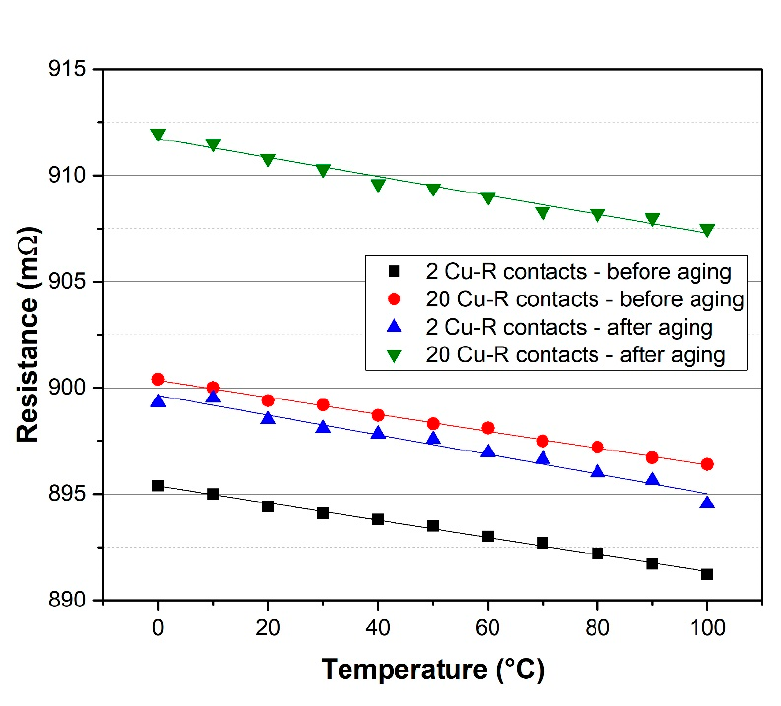
Figure 7. Temperature dependence of resistance of IRP specimens before and after accelerated aging.